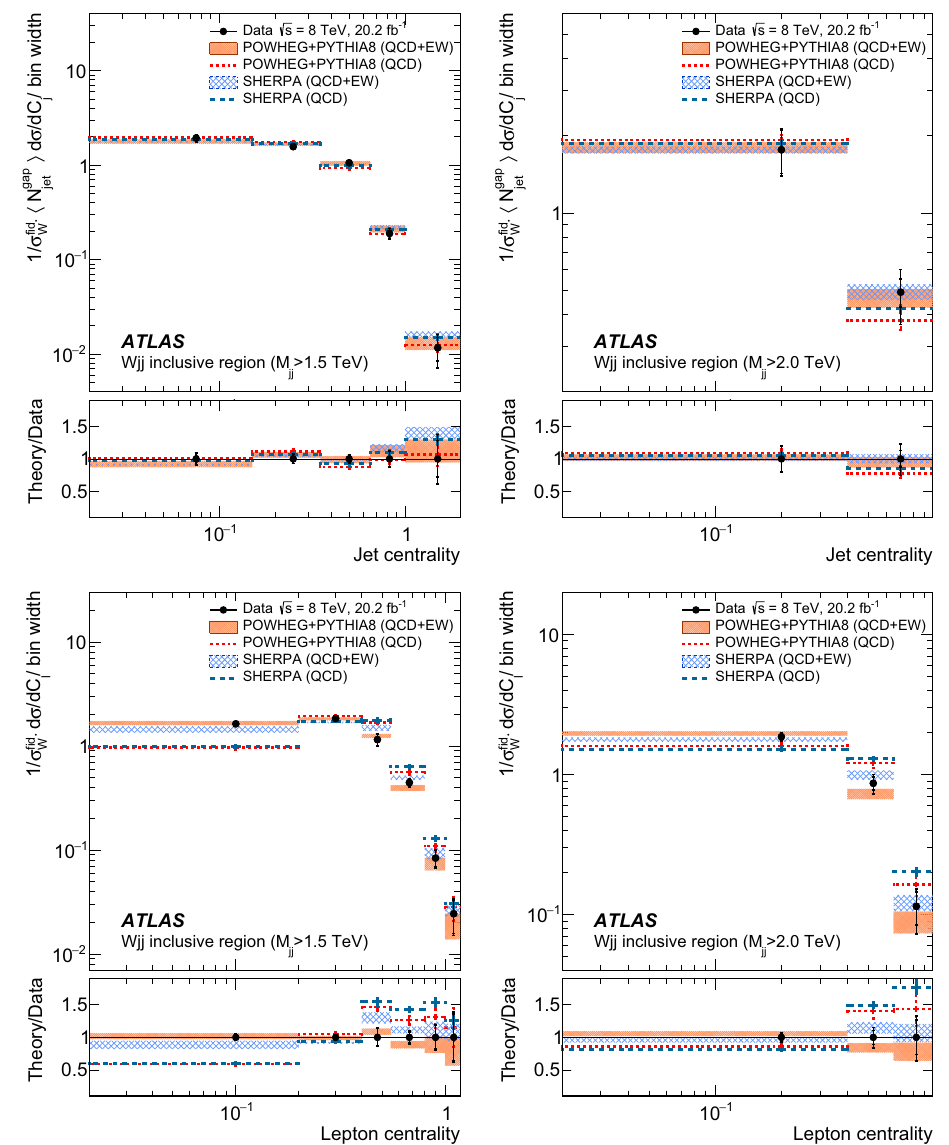
Fig. 38 Unfolded normalized differential W jj production cross sec- tions as a function of jet centrality ( top ) and lepton centrality ( bot- tom ) for the inclusive fiducial region with M jj > 1 . 5 TeV ( left ) and